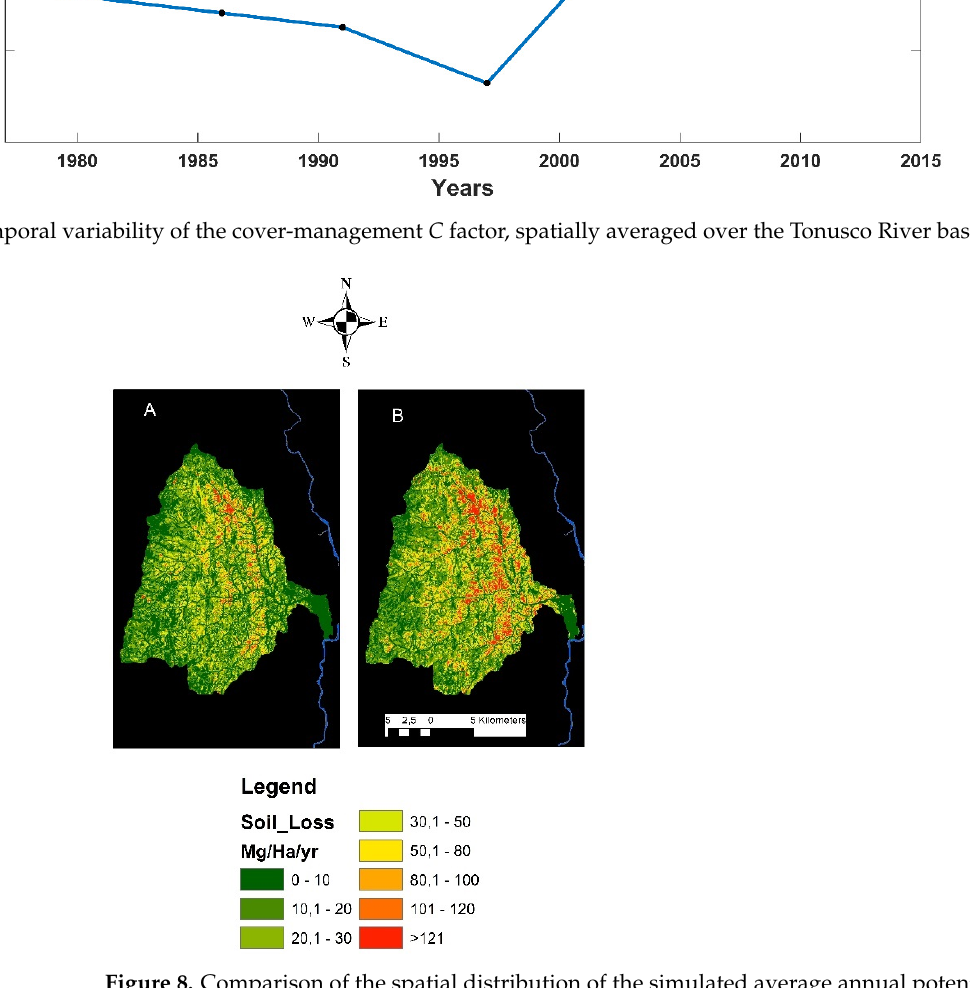
Figure 9. Evolution of the estimated soil loss over time in the Tonusco River watershed ( A ) and comparison of soil loss between El Niño, La Niña, and normal years ( B ). 3.3. Modeling Sediment Delivery Figure 10 compares the annual sediment delivery and β coefficient values, estimated with Equation (5). The results show an important year-to-year variation, with SDR and β values ranging from 0.05 to 1.00 and 0.00 to 0.161. As mentioned earlier, the sediment loads estimated between 1984 and 1986 were discarded because they were considered to be anomalous data. During this period,